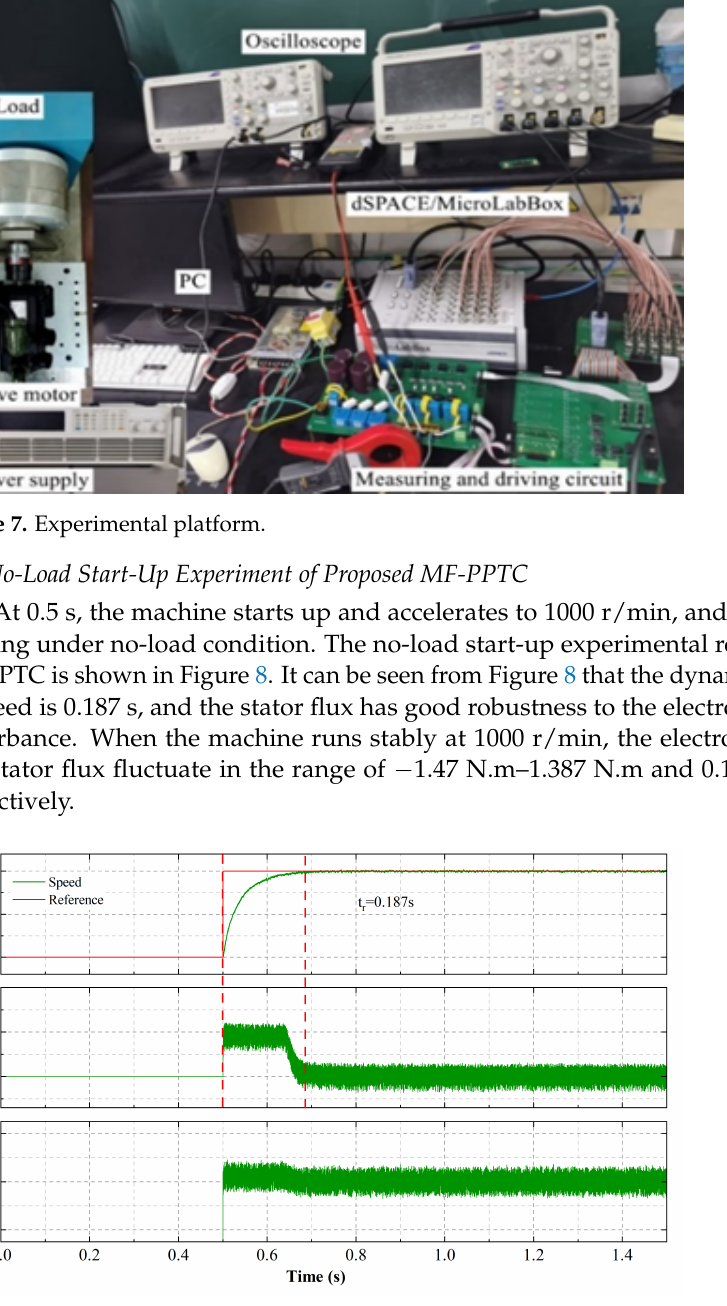
Figure 8. The no-load start-up experimental result of proposed